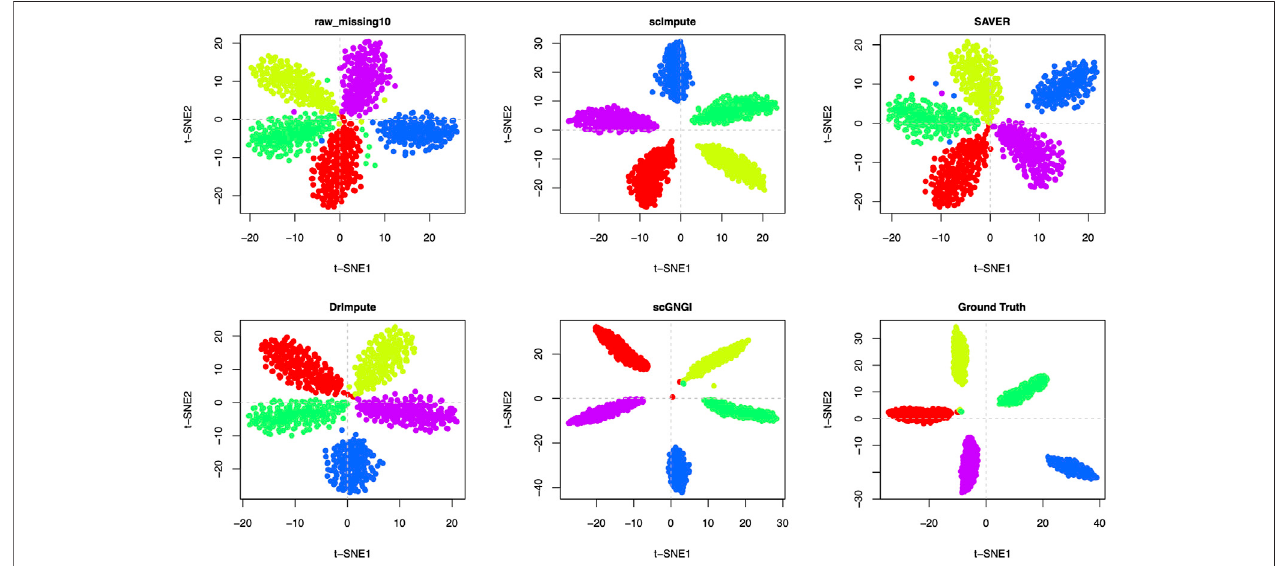
FIGURE4 | Imputation performanceon the Simulated Data1 with 5known cell types. Visualization of thecells bythe fi rst two t-SNE componentson the raw data, missing data, and imputed ones by different methods. Each dot is a single cell, and different colors represent different cell types.